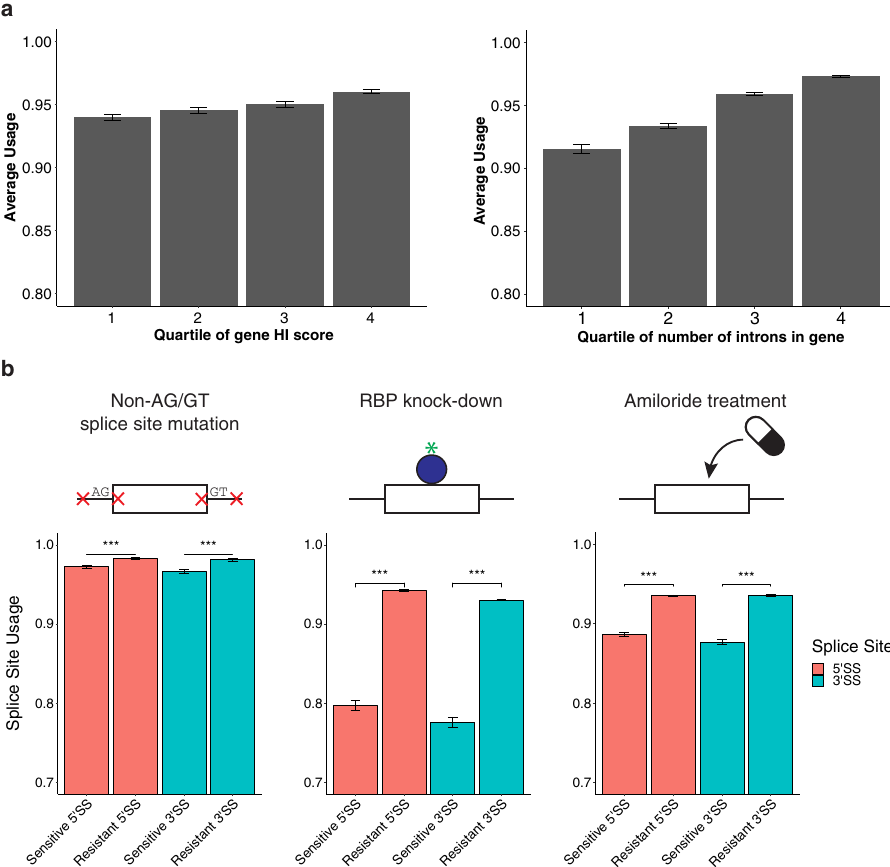
Fig. 5 Hotspot exons have lower splice site usage. a Exons in the ENCODE HepG2 dataset with splice site usage values were binned into quartiles based on either the haploinsuf fi ciency score (left, n = 6660 exons) or the number of introns (right, n = 9558 exons) in their respective genes. Data are presented as mean ± SEM. b Three separate analyses were performed on splice site usage. In the fi rst case (left), exons were categorized based on the presence of a splice site mutation reported in HGMD that lies outside of the essential AG/GT motif in canonical 5 ′ and 3 ′ splice sites ( n = 3600 exons, p = 1.912e − 8 for 5 ′ SS and p = 1.414e − 9 for 3 ’ ss (one-sided Mann – Whitney test)). In the second case (middle), exons were categorized based on whether or not splicing was affected in an ENCODE RBP knockdown study ( n = 2333 exons, p < 2.2e − 16 for both 5 ’ SS and 3 ’ SS (one-sided Mann – Whitney test)). In the last case (right), exons were categorized based on the effect of amiloride treatment on exon skipping ( n = 6820 exons, p < 2.2e − 16 for both 5 ’ SS and 3 ’ SS (one- sided Mann – Whitney test)). The average splice site usage in each case is plotted. Data are presented as mean ± SEM, and p values are adjusted for multiple